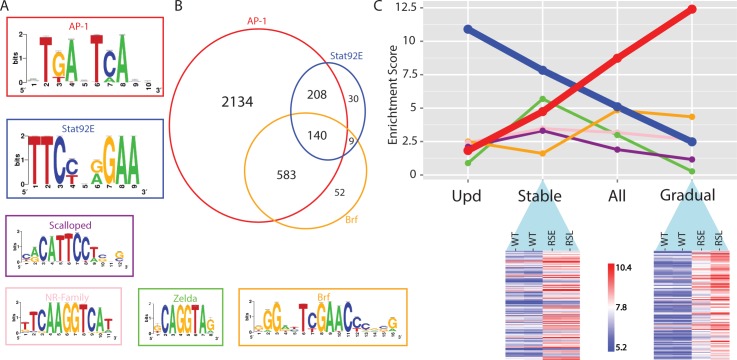
Regulator detection by motif inference.(A) Motifs enriched in the activity-gaining enhancers for the transcription factors AP-1, Stat92E, Scalloped, nuclear receptor family, Zelda and Brf. (B) Venn diagram of the tumor-specific enhancers that are predicted to be responsive to AP-1, Stat92E and Brf transcription factors. (C) The motif enrichment score (i-cisTarget) of the six transcription factors plotted for each of the four different enhancer groups; opening after Upd-overexpression (activating Stat92E), Stably opening enhancers, All opening enhancers and Gradually opening enhancers in RasV12;Scrib-/- tumors. The heatmaps are representing a subset of the regions that are classified as stably or gradually opening. A variance stabilizing transformation (DESeq2) was performed on the count data, blue indicates low and red indicates high peak intensity.